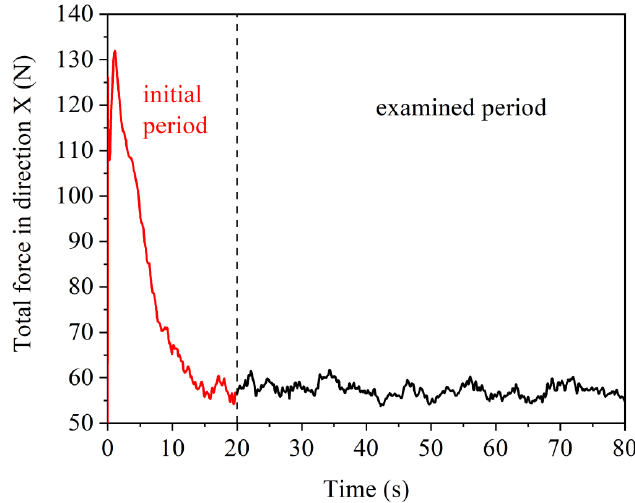
Figure 5. Total drag force fluctuation over time.